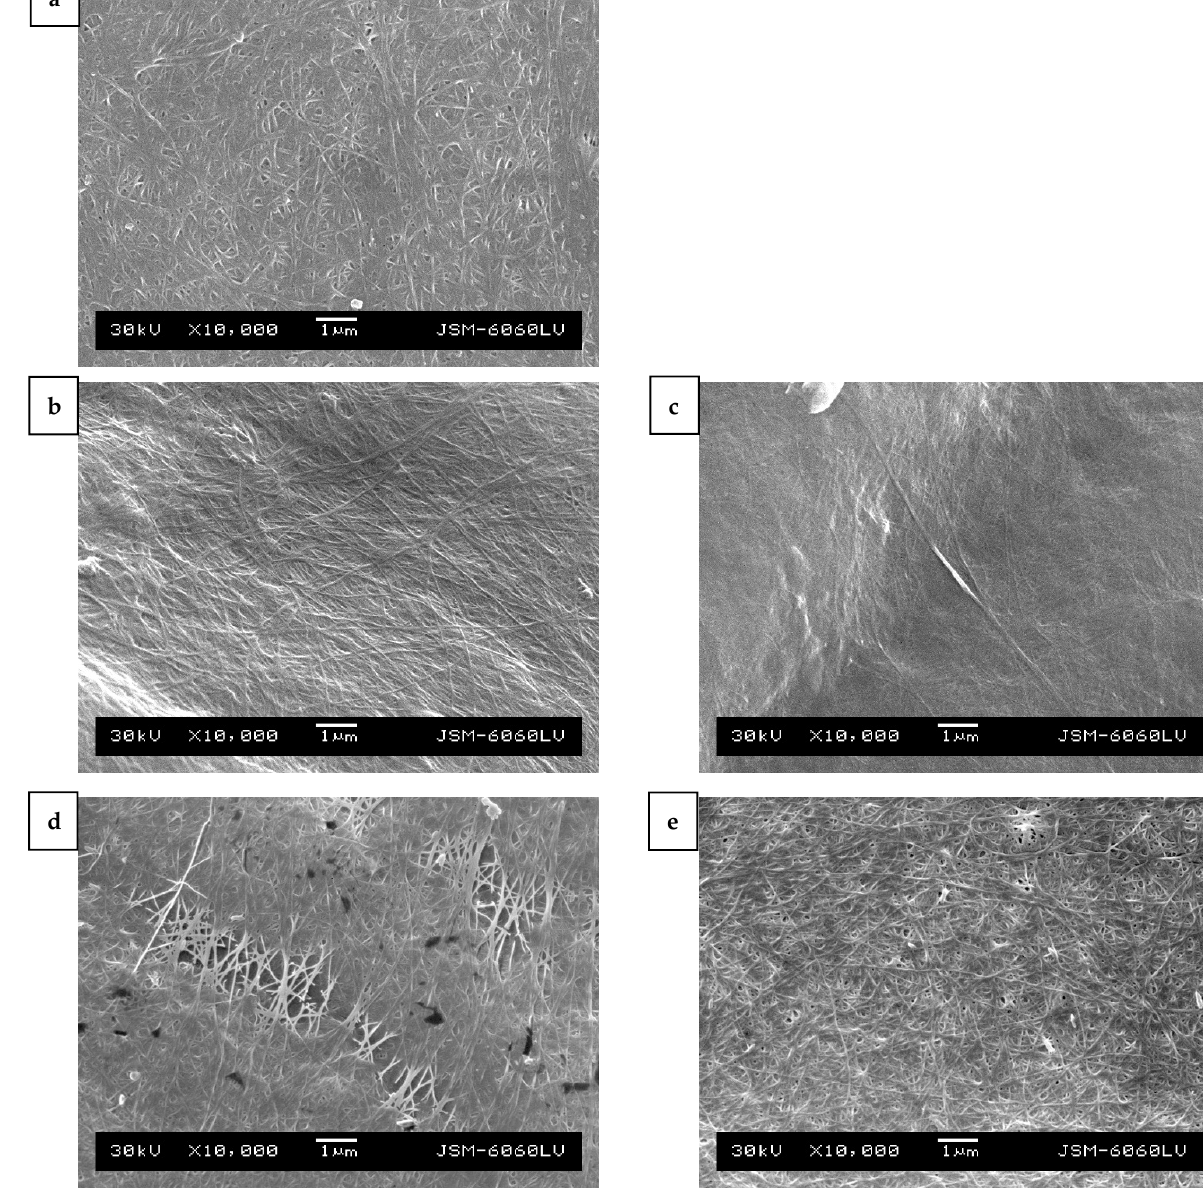
Figure 5. Scanning electron microscope images of BC films produced from ( a ) HS medium, ( b ) HS-C + WGB medium, ( c ) WGB medium, ( d ) HS-C + RGB medium, and ( e ) RGB medium.